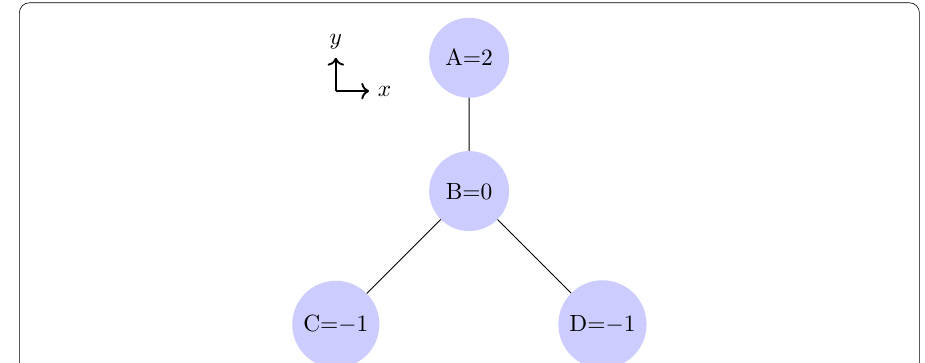
Fig. 1 A network of four nodes and three edges. The node attributes are considered forces that act in the z -direction. The forces acting on the network balance, but the forces acting on the nodes only balance when the nodes are in the appropriate position in the z -axis; the network is shown in the x – y